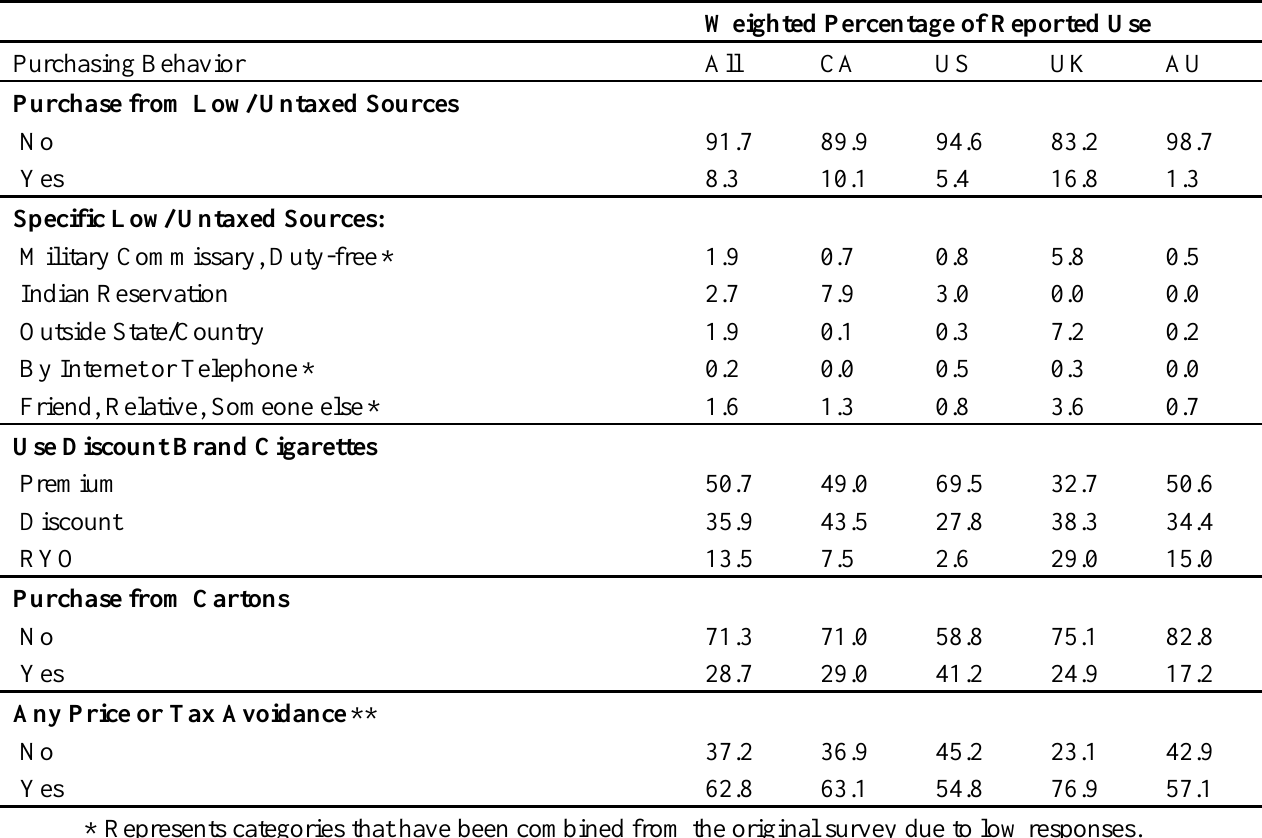
Table 3. Frequency of using low and untaxed sources at wave 5 by country (weighted percentages).